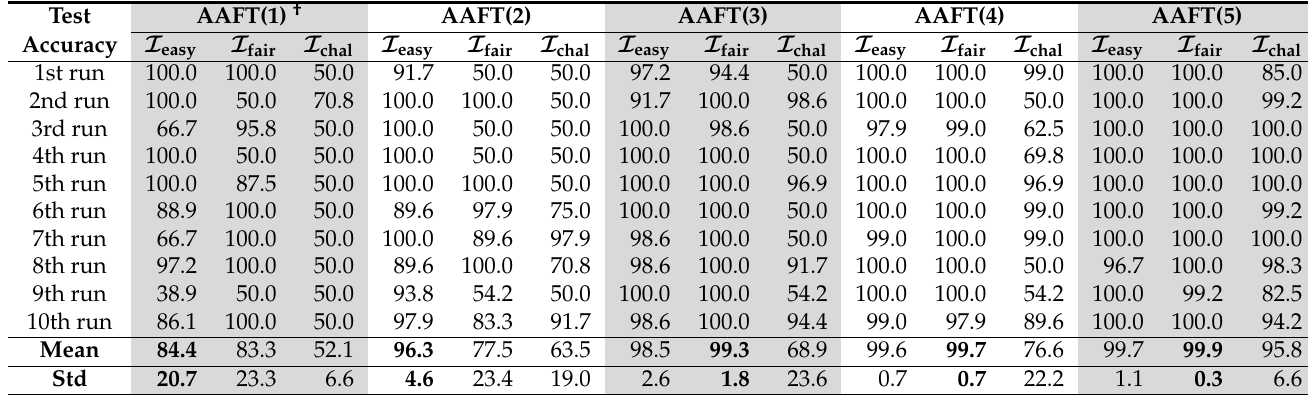
Table 2. The mean and standard deviation of test accuracy